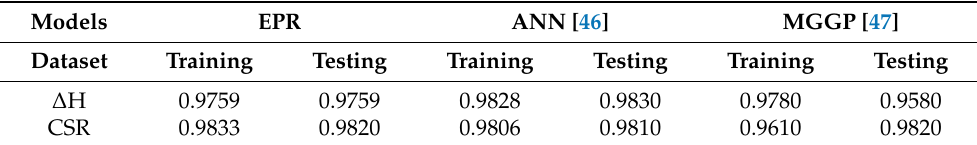
Table 11. Comparing the R 2 values of the EPR model with other models.